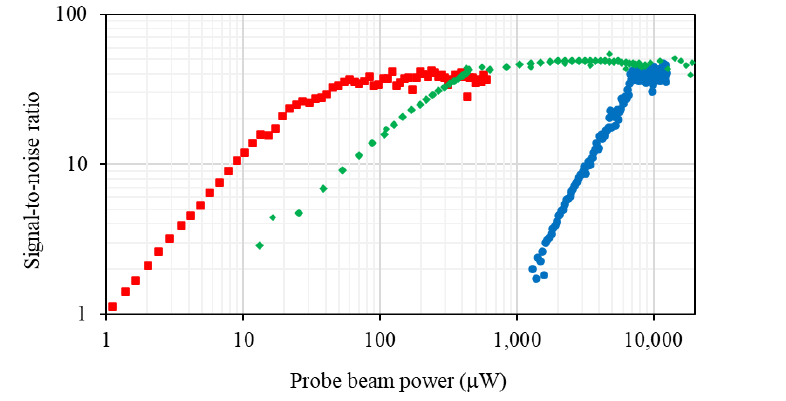
Figure 5. Signal-to-noise ratio as a function of the probe beam power for three different rf atomic magnetometer configurations: two independent pump and probe beams (red squares), a degenerate pump and probe (green diamonds), and a single beam (blue